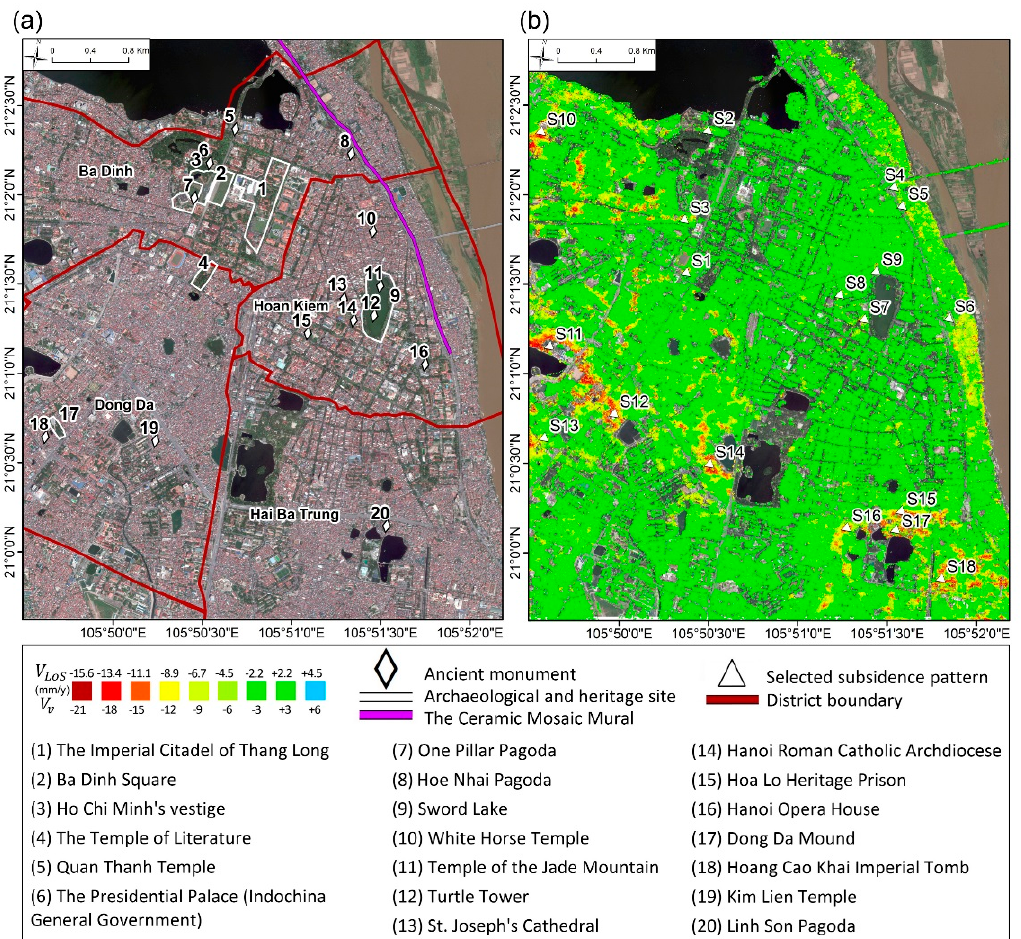
Figure 4 . ( a ) An optical satellite image acquired in September 2012 (provided by Google Earth) represents the location of historical relics, archaeological ruins and ancient monuments in Hanoi Historical Centre; ( b ) Average for April 2012–November 2013. Line-of-Sight (LoS) velocity map of Hanoi Historical Centre. Mean LoS and projected vertical velocity are in mm/year. Selected subsidence patterns are labelled from S1–S18.